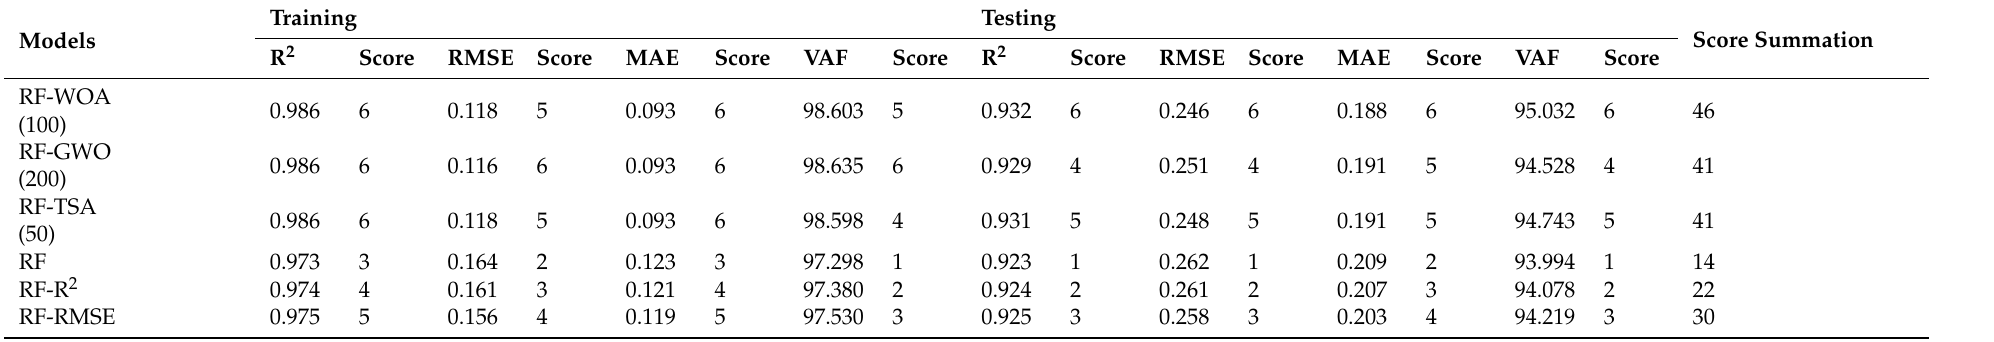
Table 6. Performance of the RF and improved RF models on predicting the